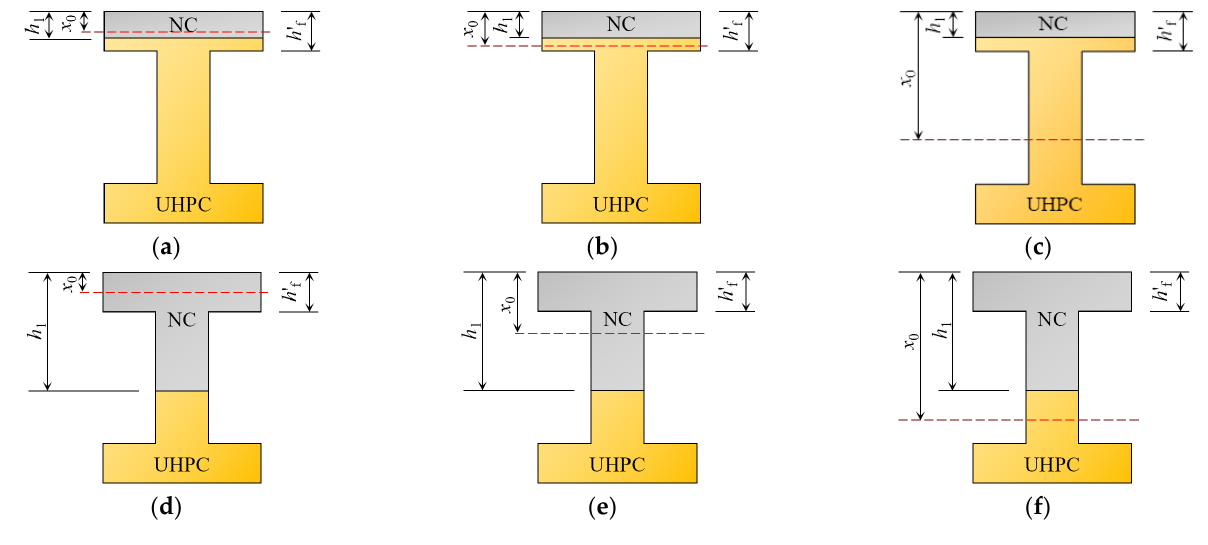
Figure 2. Type of section combination; ( a ) I; ( b ) II-I; ( c ) II-II; ( d ) III-I; ( e ) III-II; ( f ) IV.